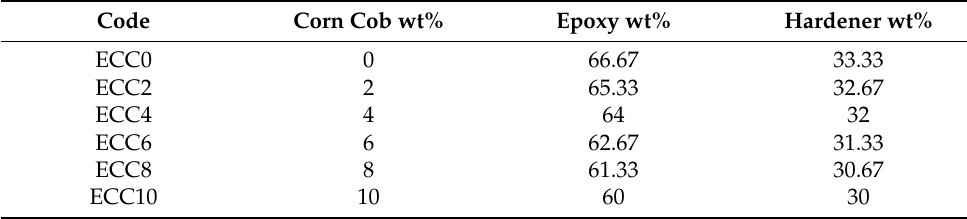
Figure 1. Schematic diagram of the epoxy composite samples’ fabrication. Table 1. Composition of epoxy/corn cob composite samples.